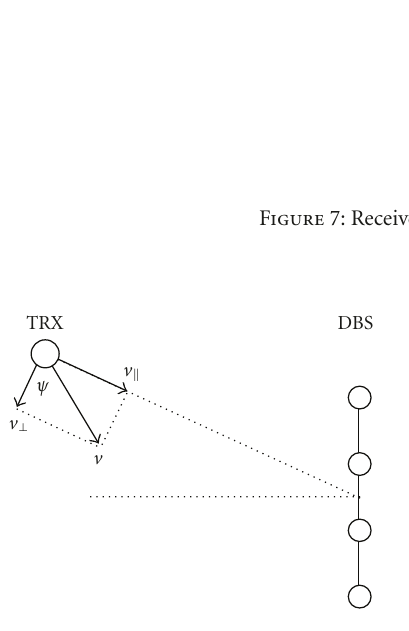
Figure 8: Relationship between v , v ⊥ , and v (cid:7)